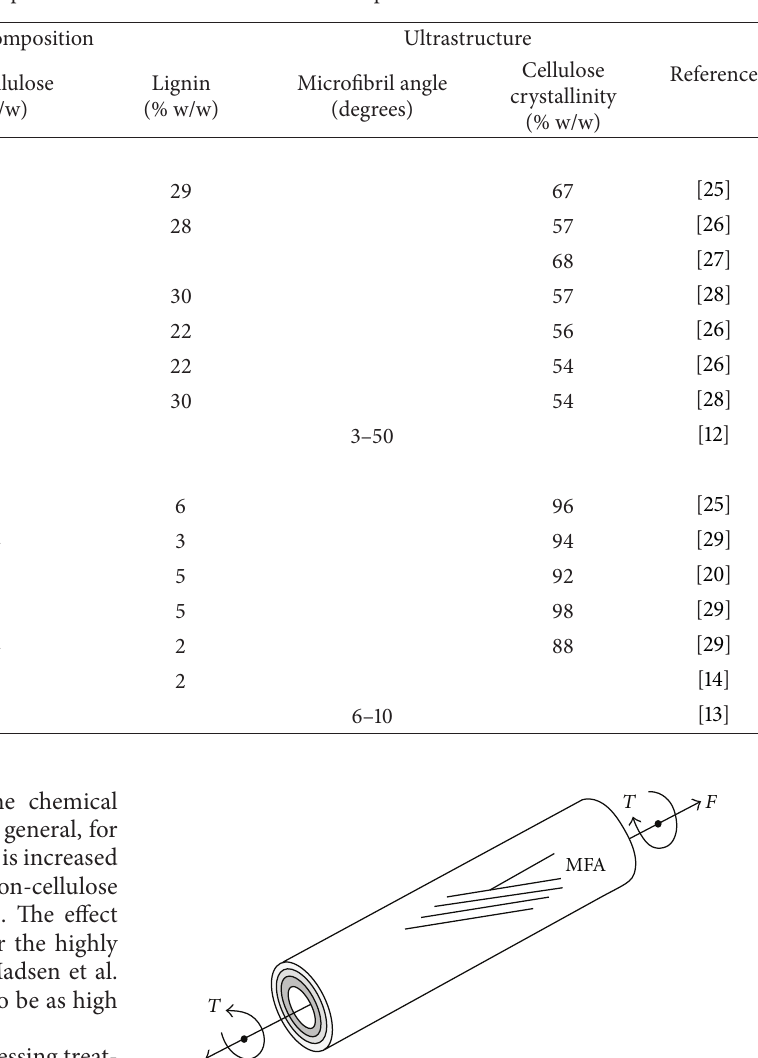
Table 1: Chemical composition and ultrastructure of wood and plant fibers.